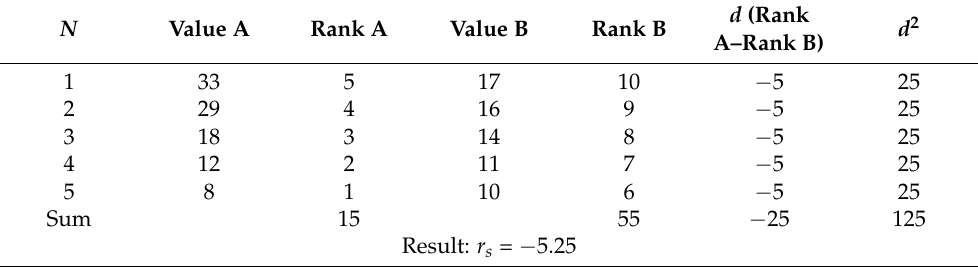
Table 5. Determination of Spearman’s rank linear correlation indicator based on the ratio of the degree of satisfaction with the use of ICT and the assessment of ICT tools that will be in demand in the near future in the activities of industrial enterprises of the Republic of Mordovia.